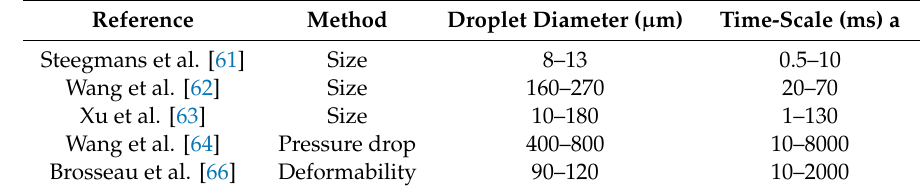
Figure 7. Microscopic images during or after interfacial tension measurement based on droplet size ( A ) [61], ( B ) [62], and ( C ) [63]; pressure drop ( D ) [64]; and droplet deformation ( E ) [66]. Images reprinted with permission of Springer [69]. Table 3. Overview of microfluidic tensiometric methods, and characteristic values.